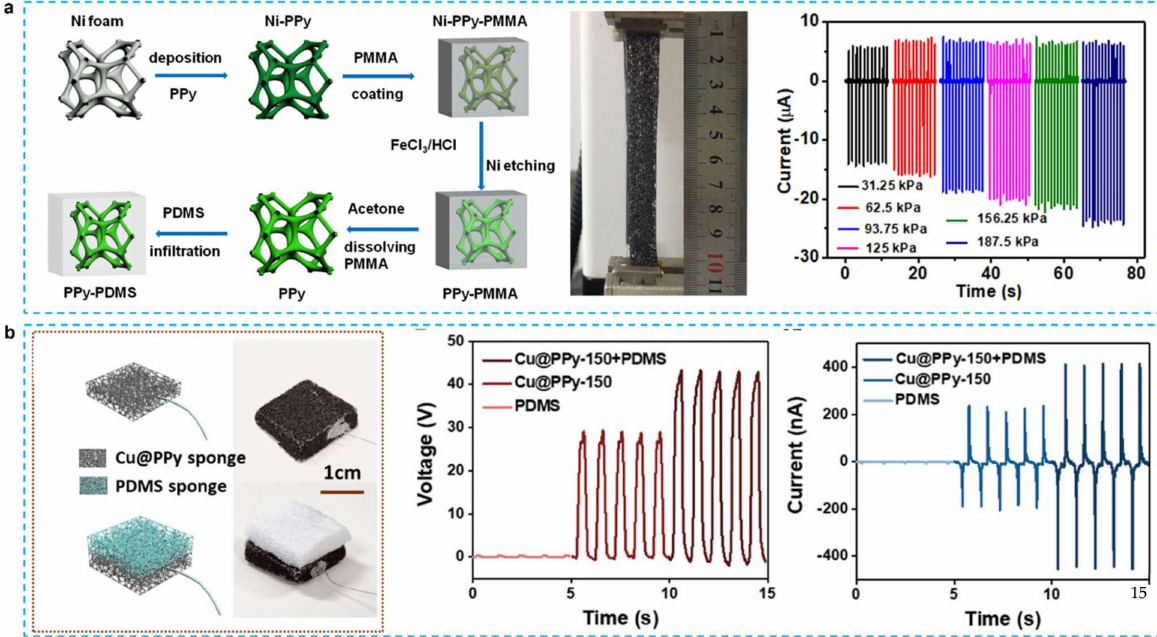
Figure 9. ( a ) Stretchable 3D polymer for simultaneously mechanical energy harvesting and biomimetic force sensing [29]. ( b ) Elastic Cu@PPy sponge for hybrid device with energy conversion and storage